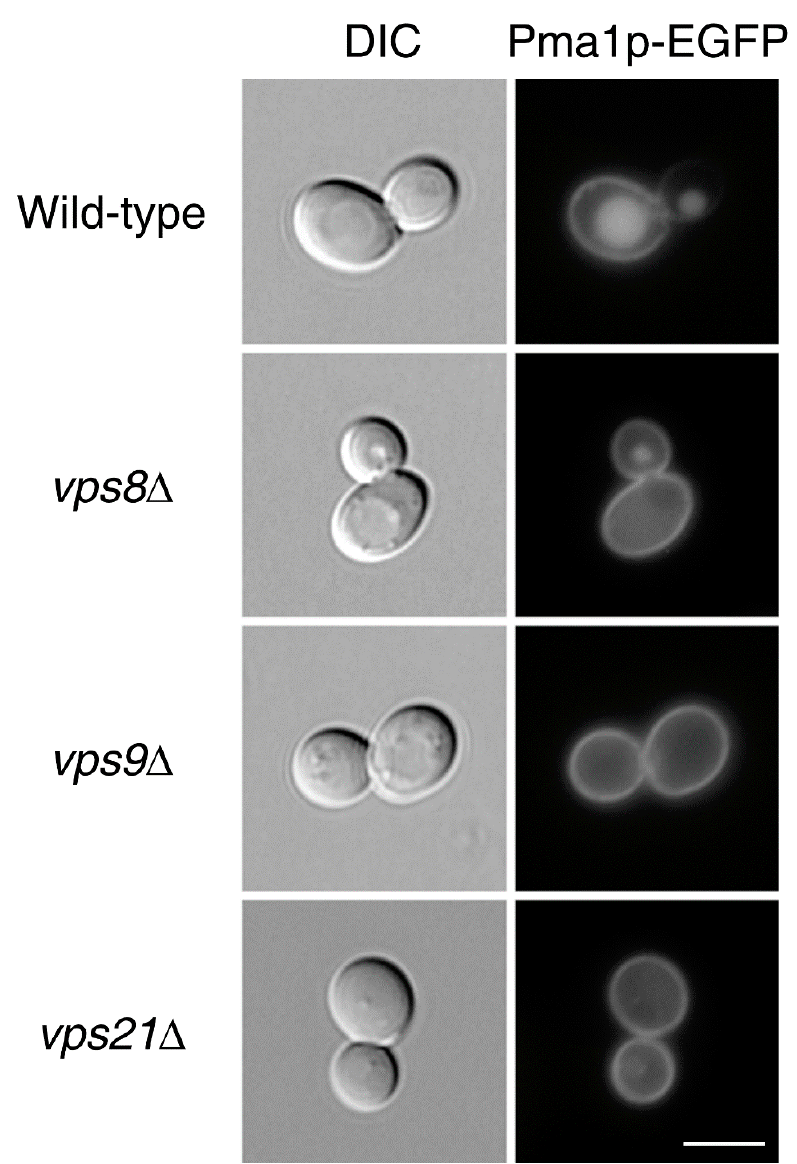
Figure 2. Deletion of VPS8 , VPS9 , or VPS21 disrupts Pma1p-EGFP asymmetry between mother and daughter cells during cell division. Wild-type cells or cells deleted for VPS8 , VPS9 , or VPS21 expressing Pma1p-EGFP under the PMA1 promoter were analyzed by fluorescence microscopy (magnification: 100 × ). Differential interference contrast (DIC) images ( left ) and GFP fluorescence images ( right ) are shown. About 100 cells per wild-type or mutant were analyzed, and representative images are shown. Scale bar: 5 μ m.